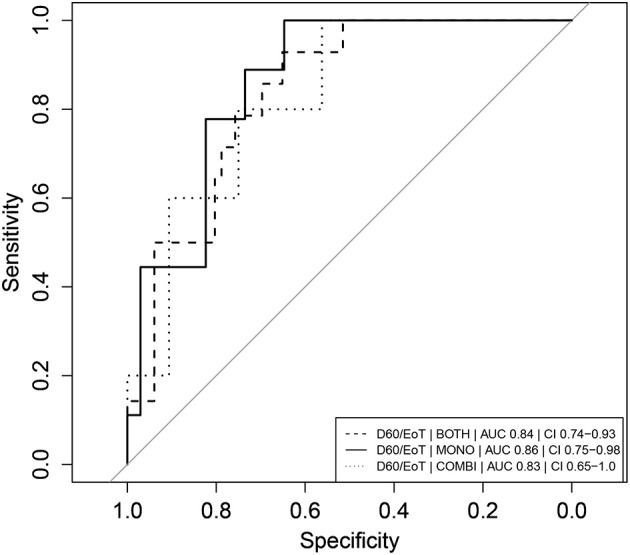
Receiver operator characteristic (ROC) curves of D60/EoT neopterin concentration ratio as predictor of clinical relapse. Receiver operator characteristic (ROC) curves of D60/EoT neopterin concentration ratio as predictor for treatment failure (relapse = 1, cure = 0). Combination therapy is indicated as “COMBI,” monotherapy as “MONO” and data of the two arms combined as “BOTH.” AUC represents the integrated area under the ROC curve. CI refers to the confidence interval of the calculated AUC.